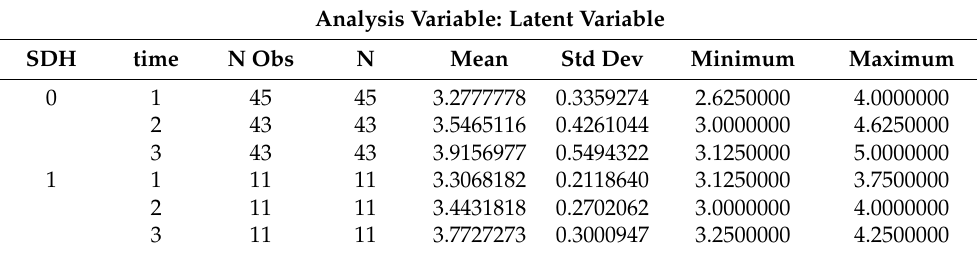
Table 6. Means (SD) of Latent Variable for SDH Group vs. Non-SDH Group *. Analysis Variable: Latent